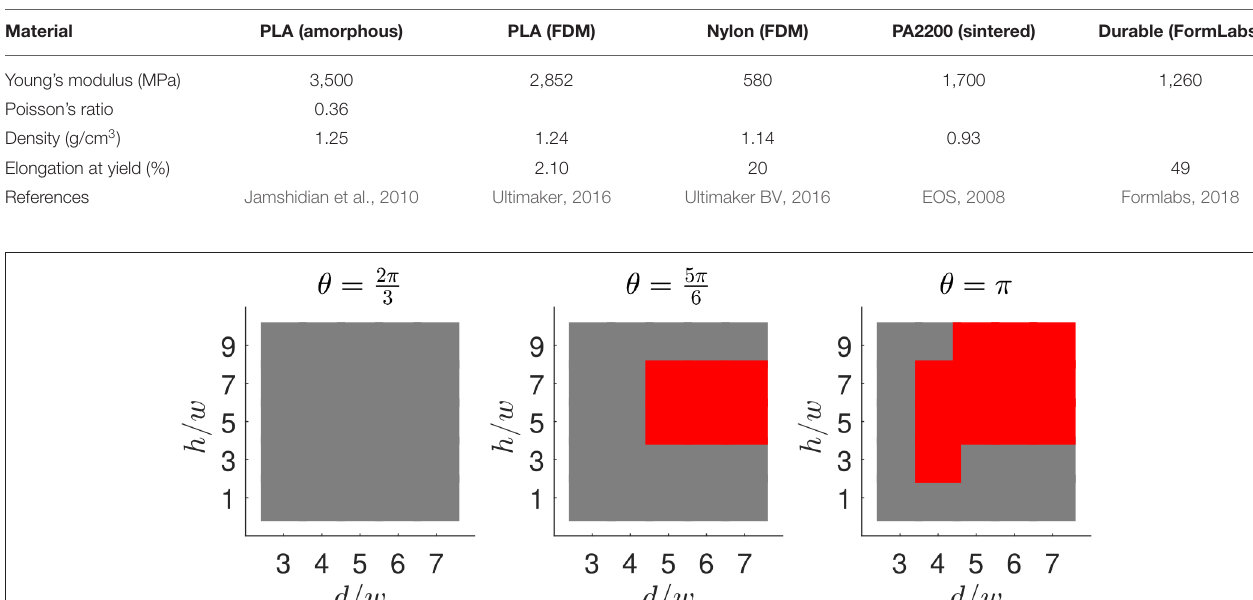
TABLE 1 | Mechanical properties of typical thermoplastic materials, and some proprietary materials used in commercial printers.